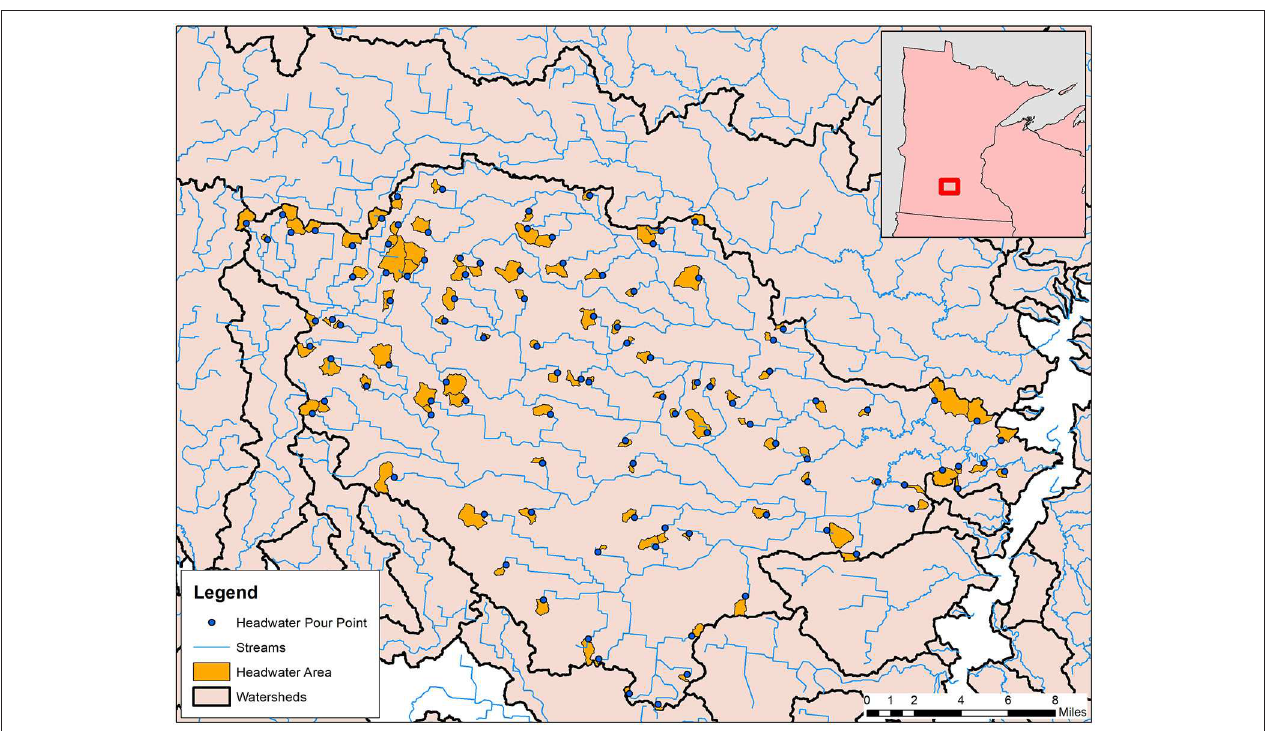
FIGURE 2 | Headwater area analysis for Minnesota utilizing NHD flowlines within a select watershed. Blue dots represent the pour points placed to model the fraction of the watershed comprised of headwater areas not subject to filtration by riparian buffers.